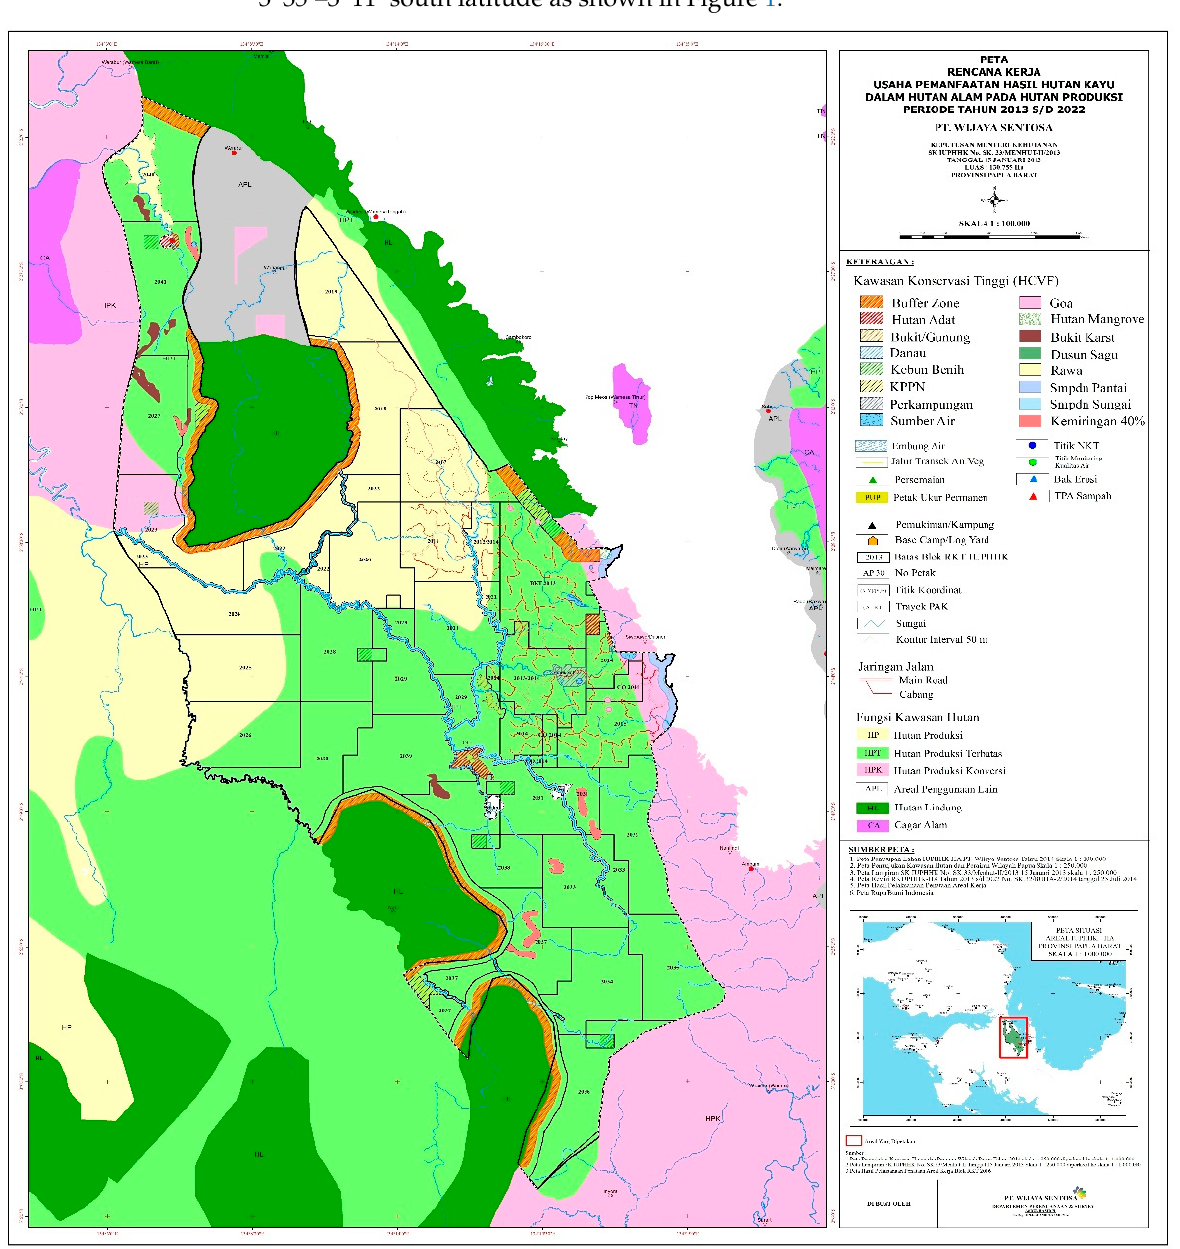
Figure 1. The position of the research site in the forest concession area of Wijaya Sentosa in West Papua, Indonesia.